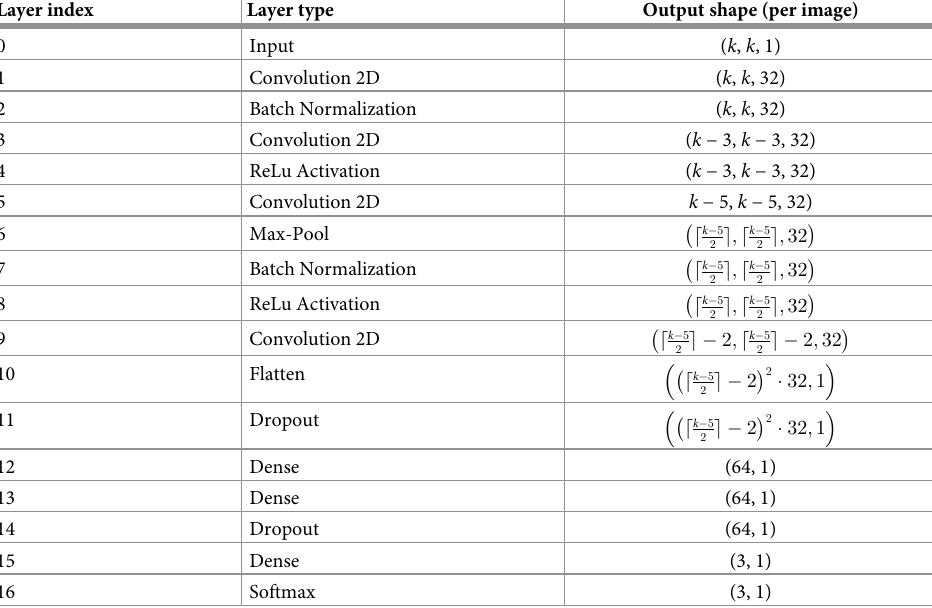
Table 1. The layer connectivity proceeding from the input layer (top) down to the output layer. Our representation of image data within the convolutional stack is ‘channels last’. The batch size is implicitly 1 for each image and is dropped. If k > 20, an additional max-pool operation is performed before layer 10. No bias weight is used in the final dense